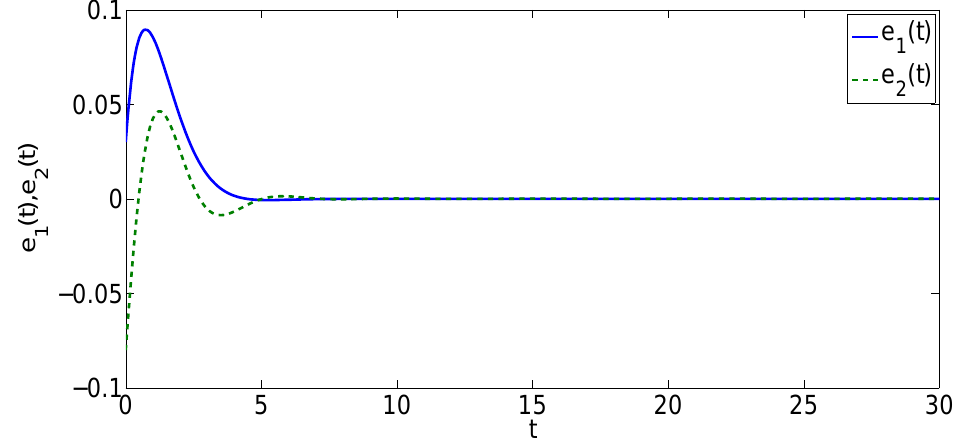
Figure 3. Evolution of synchronization errors e 1 ( t ) , e 2 ( t ) in Example